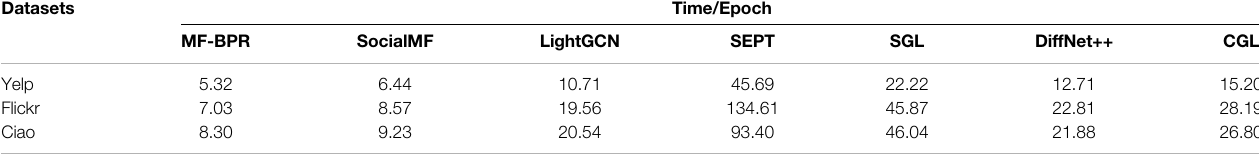
TABLE 6 | Average epoch runtime of all models (seconds).